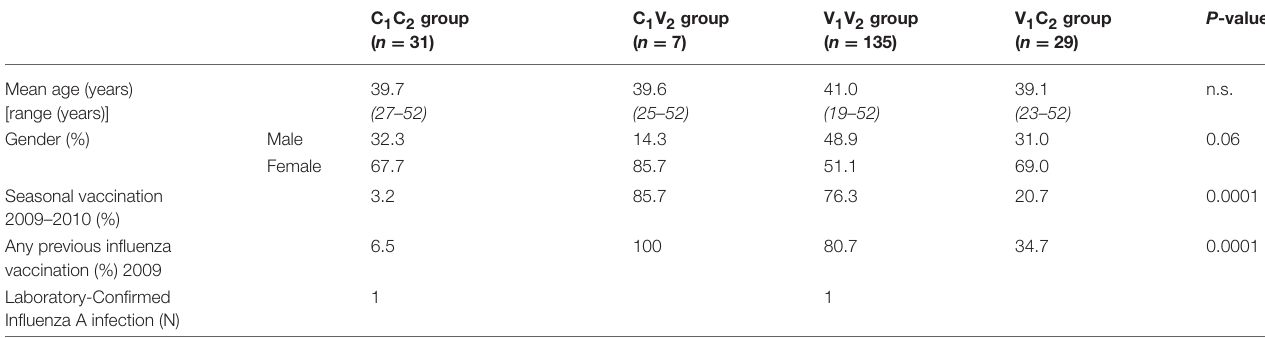
Table 1B | Baseline characteristics season 2 (2010–2011).